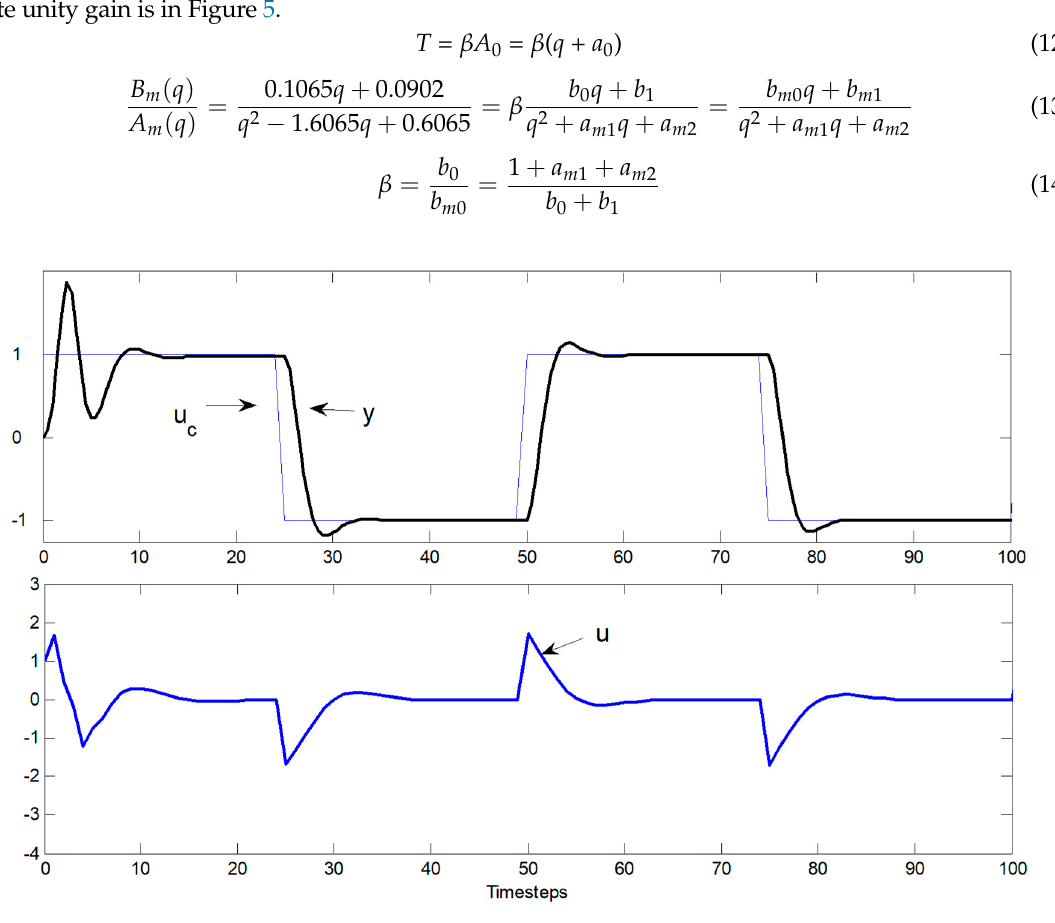
Figure 3 . Control u ( t ) output y ( t ) versus time for indirect self-tuner (no zero cancellation) of minimum phase system.